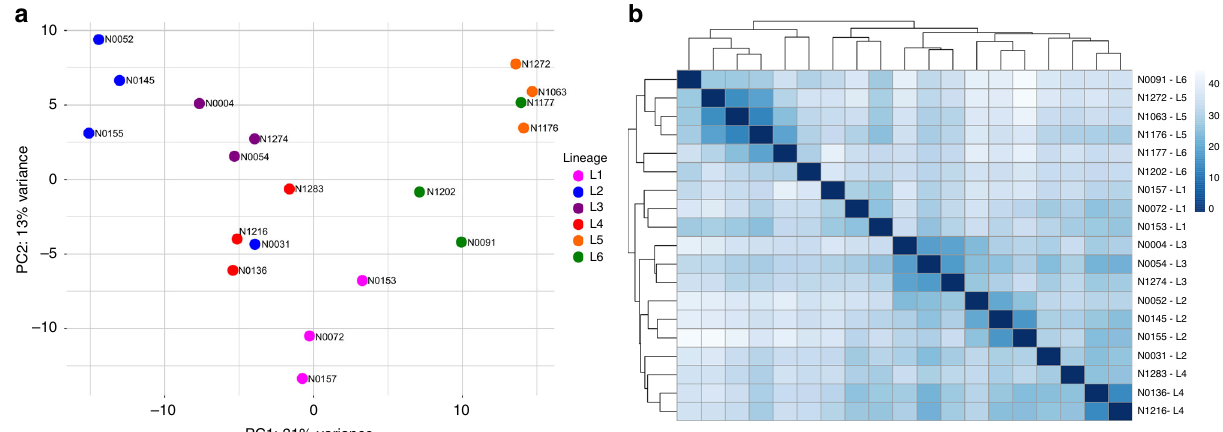
Fig. 1 Global transcriptomic pro fi les of the samples. a The PCA plot shows that samples belonging to the same phylogenetic clade tend to group closely, except for two cases. b A cluster analysis reinforces the trend derived from the PCA, with almost all the samples belonging to the same lineage clustering together. The heatmap colour scale re fl ects the Euclidean distance between each sample, calculated from the complete